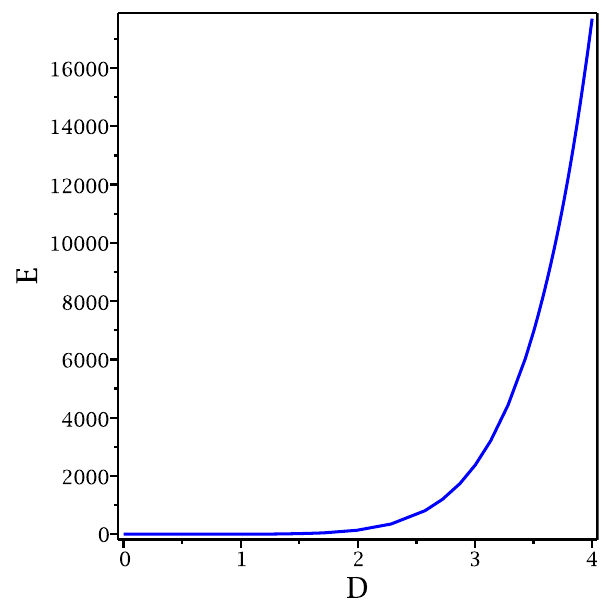
Fig. 7 The energy E vs radius D . We have chosen σ 0 = 1, δ = 0 . 01, A 0 = 1, (cid:8)(ε) = − 1, m = 2 and H (ε) = 1 . 1